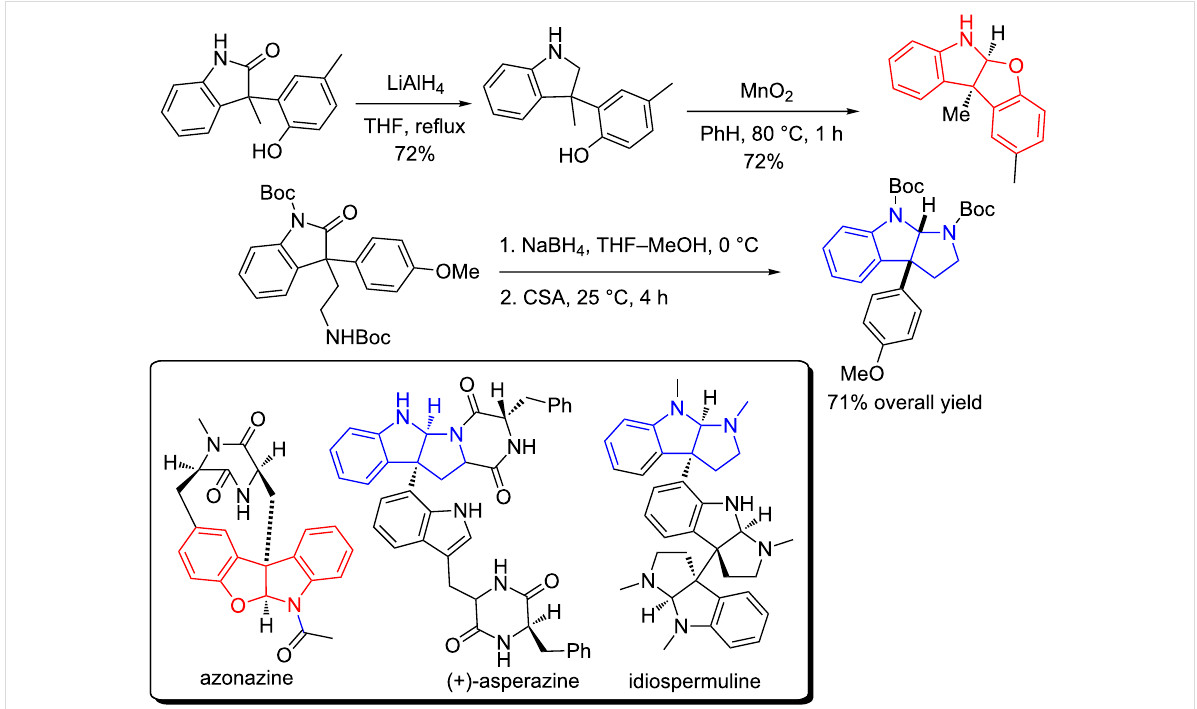
Scheme 48: Synthetic application of 3-arylated disubstituted oxindoles in the construction of core structures in natural products.